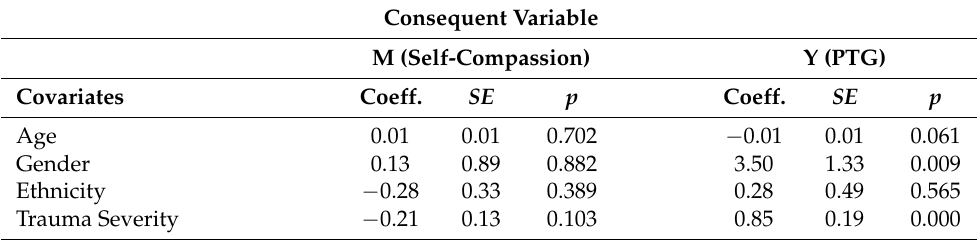
Table 2. Model coefficients for the simple mediation model for PTSD symptoms, self-compassion, and PTG (Path a , b , c (cid:48)